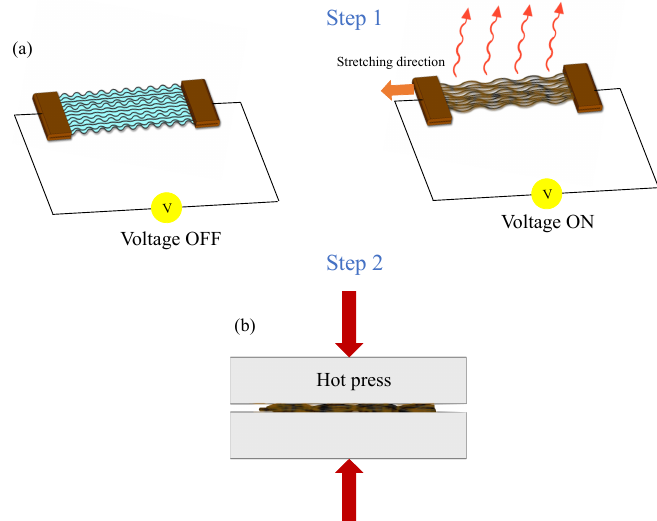
Figure 1. Schematic illustration of a two-step process for fabricating polymer-carbon nanotube (CNT) composites. ( a ) Step 1 shows the experimental setup of the fabrication of polymer-CNT composite, while ( b ) Step 2 shows the final composite manufacturing process where the composite is cured in a hot press under